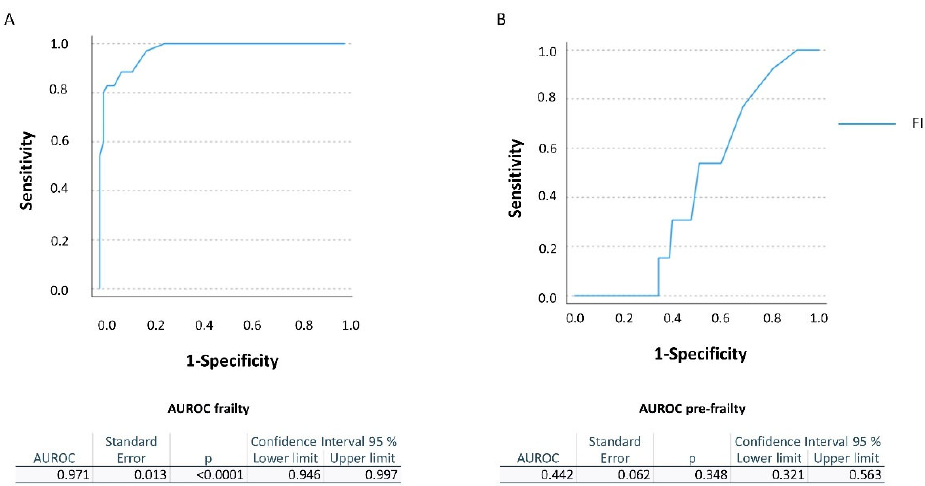
Figure 1. ROC curves for the FP and FI . ( A ) The AUROC for the FI in diagnosing frailty compared to the FP. ( B ) The AUROC for the FI in diagnosing pre-frailty compared to the FP. The two tests moderately agreed (43.3%, K Cohen = 0.116) on classifying pre ‐ frail